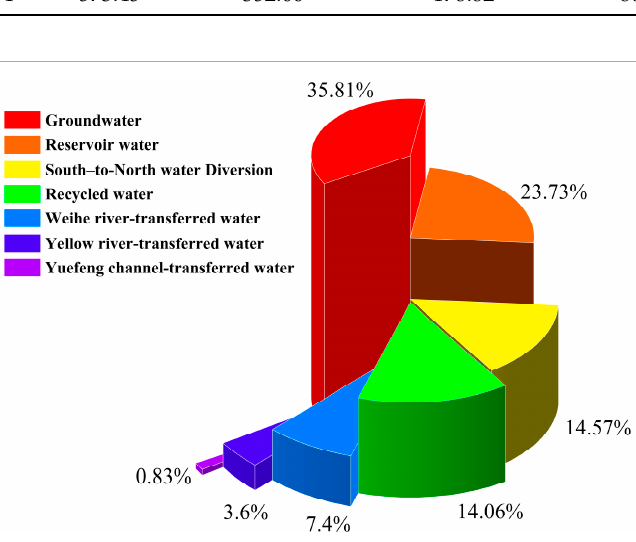
Figure 5. The proportion of water supply from different sources.